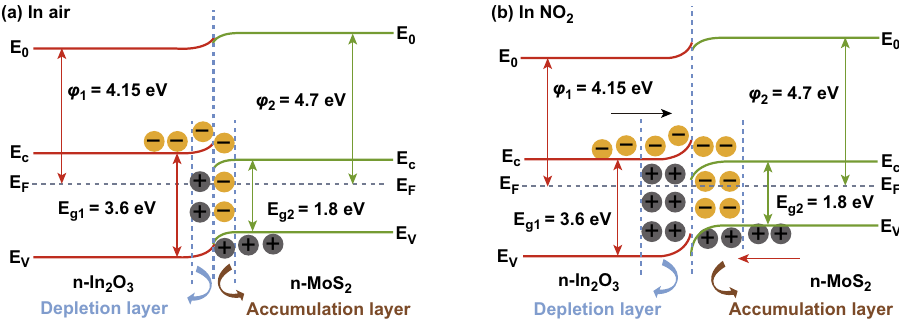
Fig. 21 Energy band diagram of In 2 O 3 /MoS 2 heterojunction in a air and b NO 2 ambient. Reproduced with permission from Ref. [346]. Copy- right (2019)